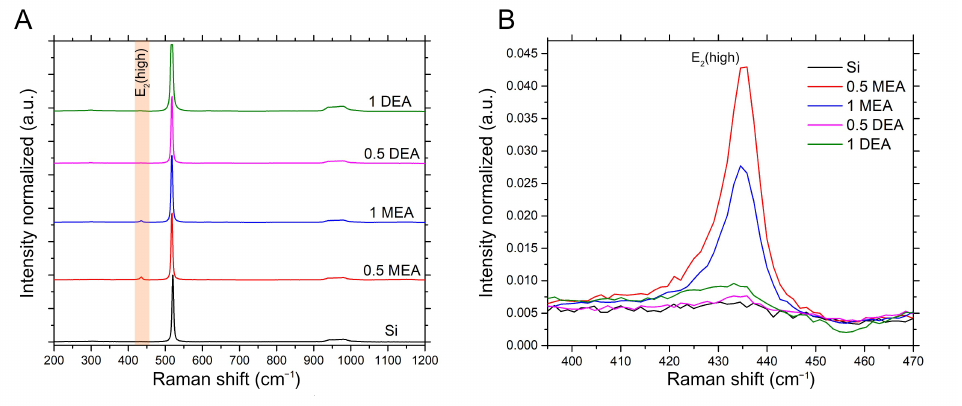
Figure 9. Raman spectra for samples grown on silicon. ( A ) The whole range of spectra normalized to the most intensive peak; ( B ) the spectrum section for the fragment marked in orange on A. showing a comparison of the relative intensity of the E 2